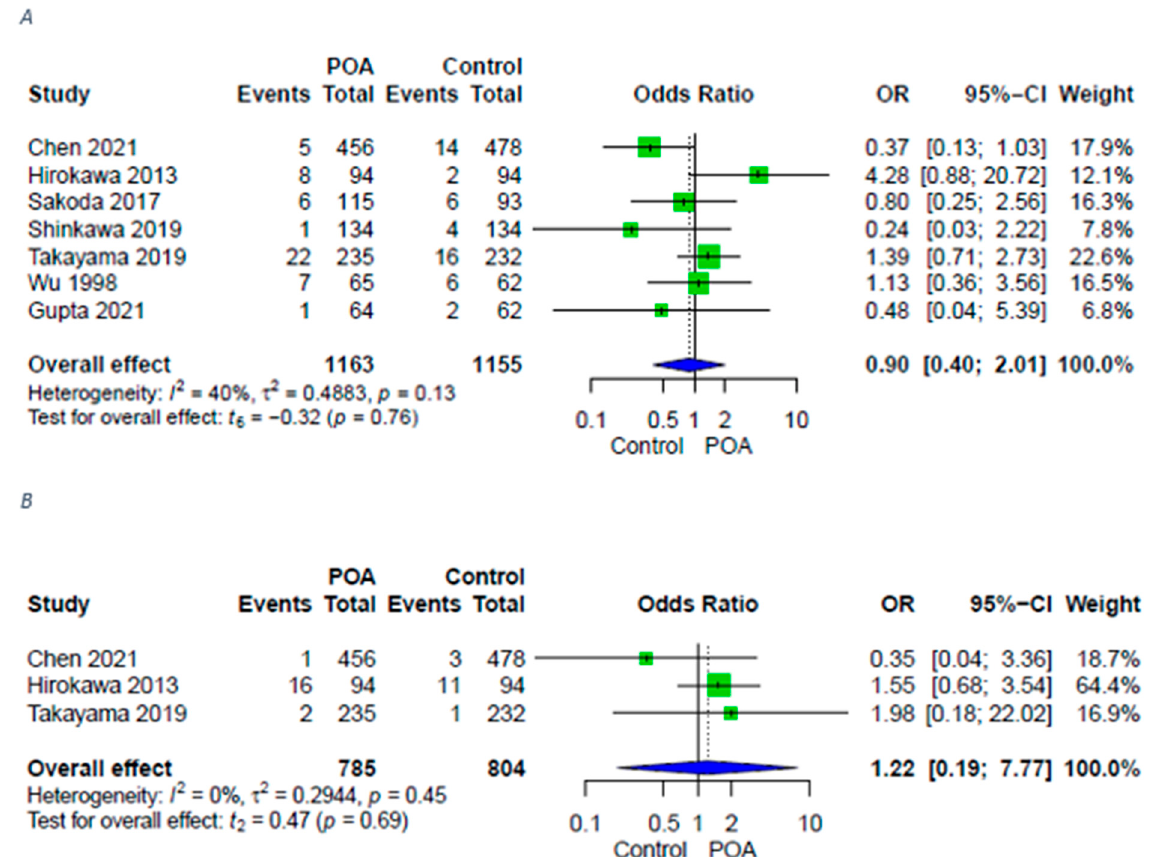
Figure 3. Forest plots for remote infections in patients with POA versus control. ( A ) Forest plot for remote infections in patients with POA versus control; ( B ) Forest plot for sepsis in patients with POA versus control. A random-effects model was utilized for all outcomes due to heterogenic methodological and clinical framework of included studies. Statistical heterogeneity was evaluated using the I 2 statistics. An I 2 value below 25% indicated low heterogeneity, while over 75% was considered high.